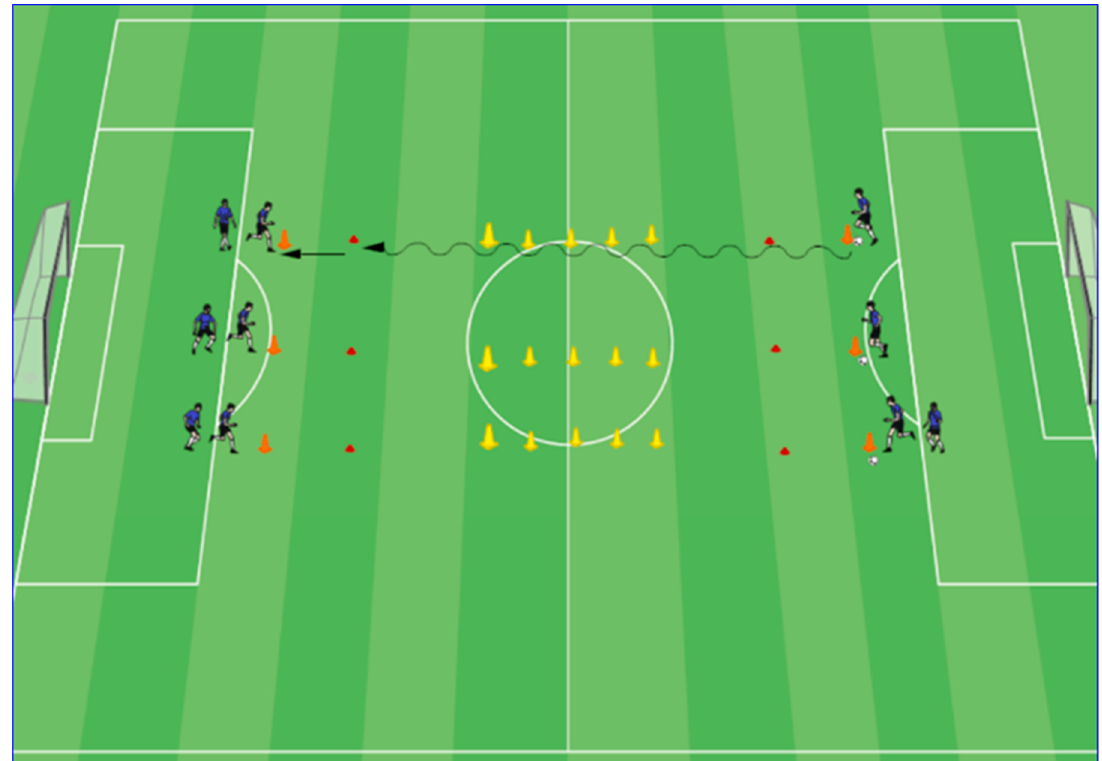
Figure 1. Schematic diagram of the soccer-specific exercise protocol of dribbling with a ball.